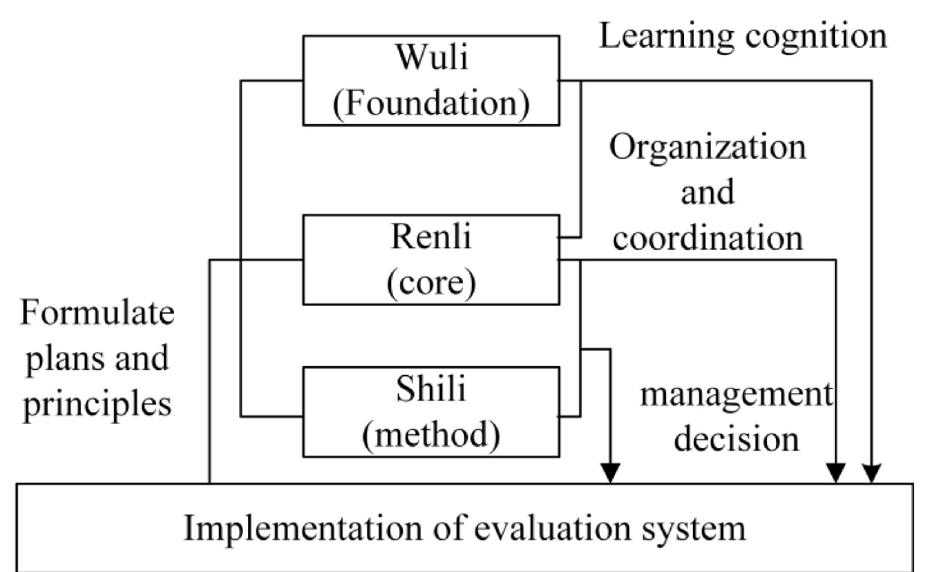
Fig 2. Evaluation model of brownfield redevelopment based on